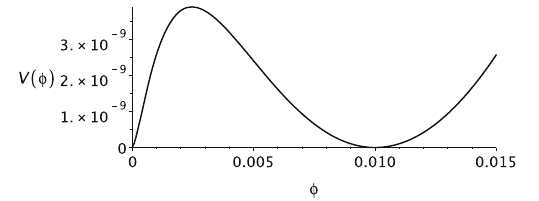
Fig. 6 The potential (27) for the parameter values k ( M lo w ) = 200 , a ( M lo w ) = 150. The parameter “ c ” is fixed by (34)